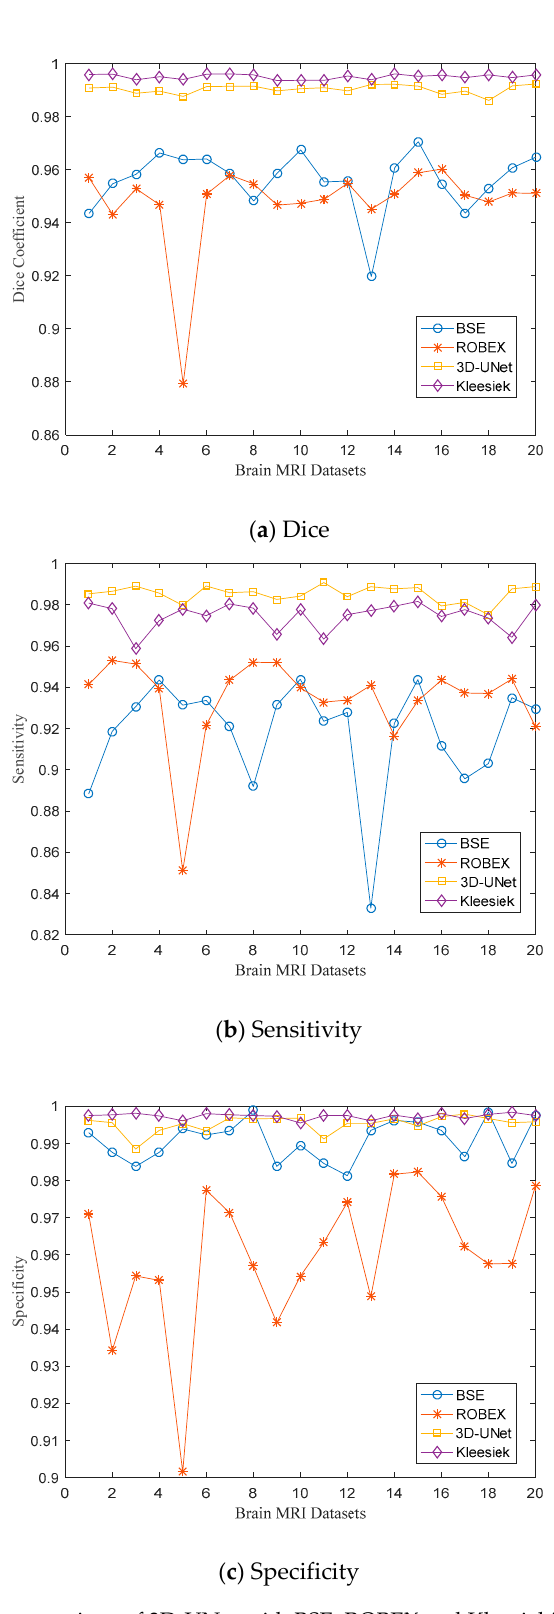
Figure 2. Quantitative comparison of 3D-UNet with BSE, ROBEX and Kleesiek’s method on test scans from NFBS database of brain MRIs. 3D-UNet shows more consistent results as compared to BSE and ROBEX. ( a ) Kleesiek's Method shows the highest performance. BSE and ROBEX have large fluctuations. ( b ) 3D-UNet has the highest performance. As in Dice's standard, BSE and ROBEX are highly volatile. ( c ) Kleesiek's Method has the highest performance and ROBEX has the lowest performance.